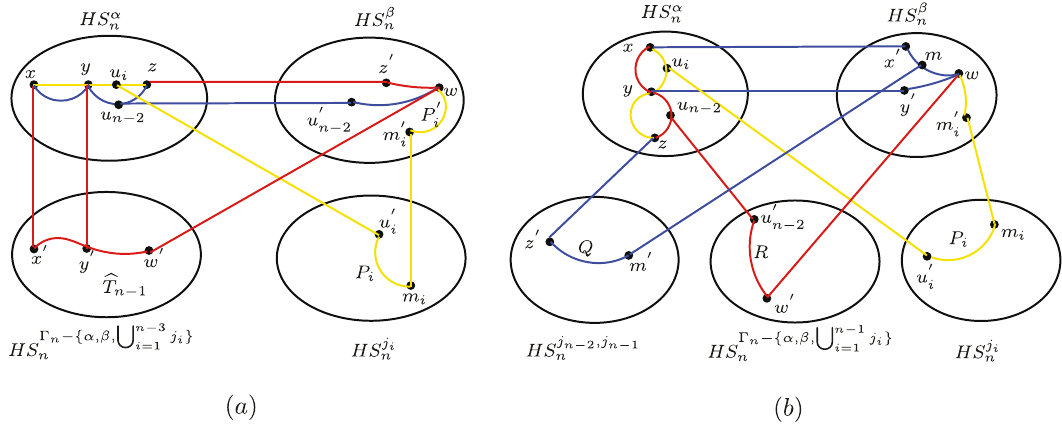
Figure 7: The illustrations of ( a ) Case 2.3.1 and ( b ) Case